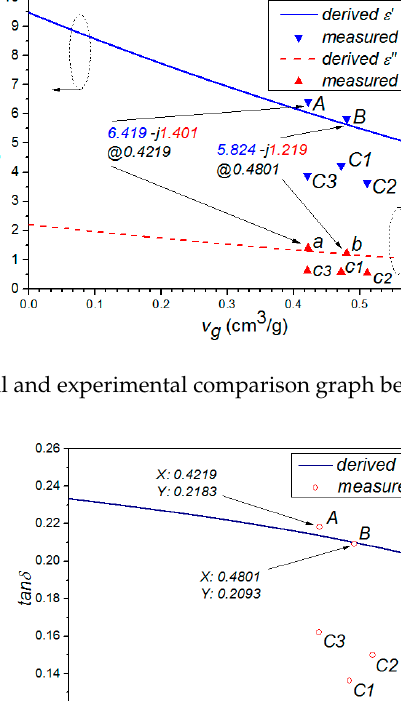
Figure 3. Theoretical and experimental comparison graph between tan δ ( ε eff ) and v g .